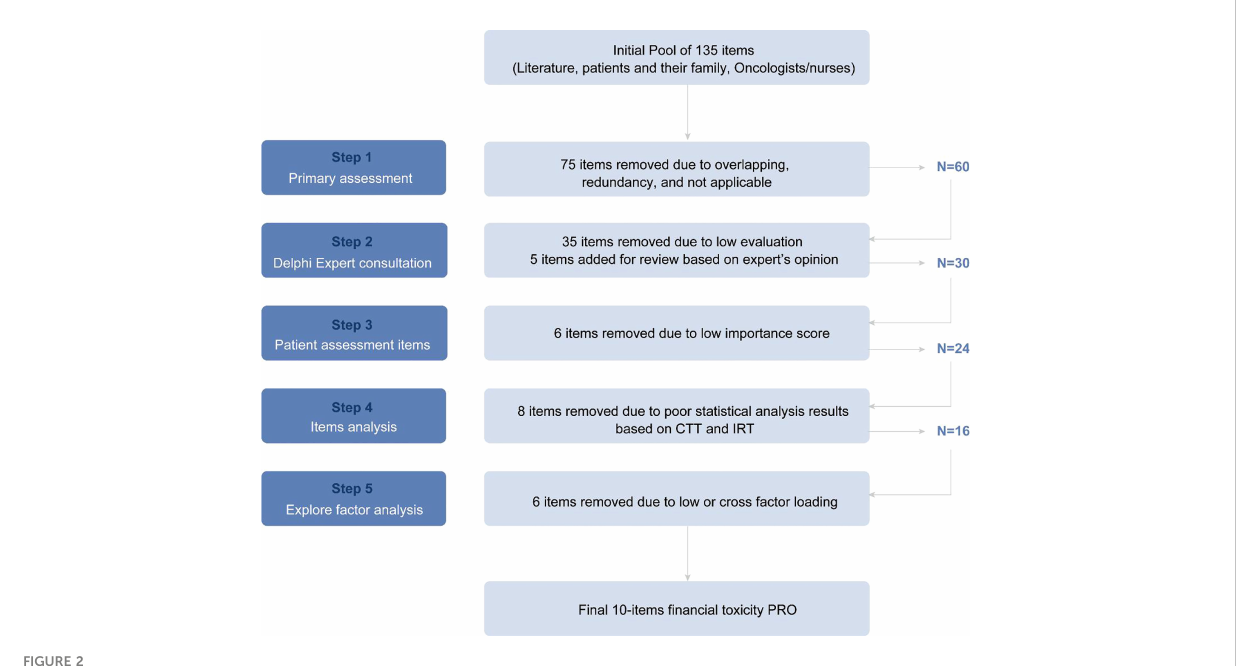
FIGURE 2 Flow chart of items inclusion and